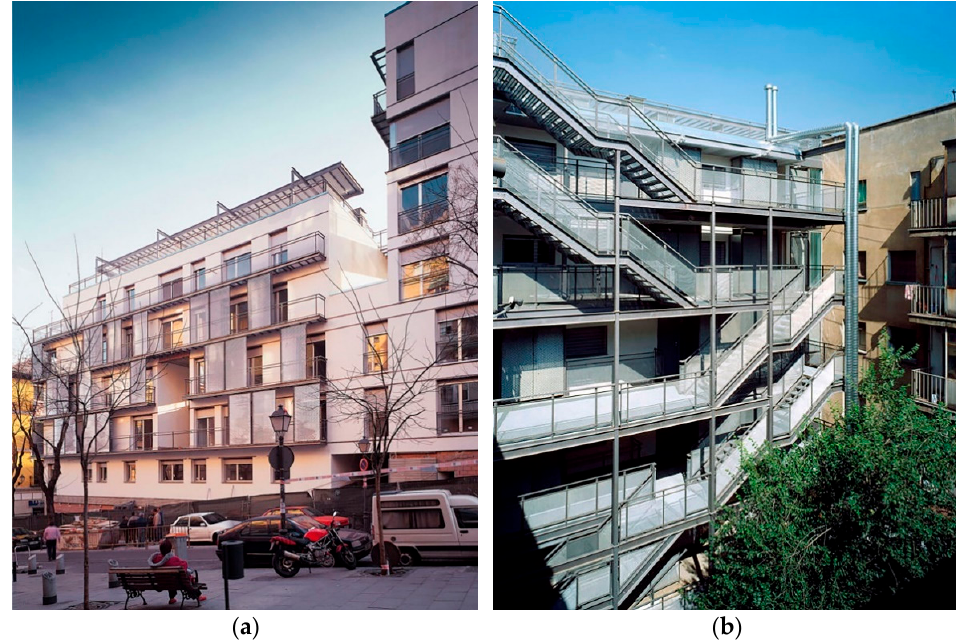
Figure 7. Rehousing complex in Madrid, Spain, ( a ) and its corrala (patio) ( b ) by Carmen Espegel. Photos: Ángel Baltanás, María Domínguez Lino.